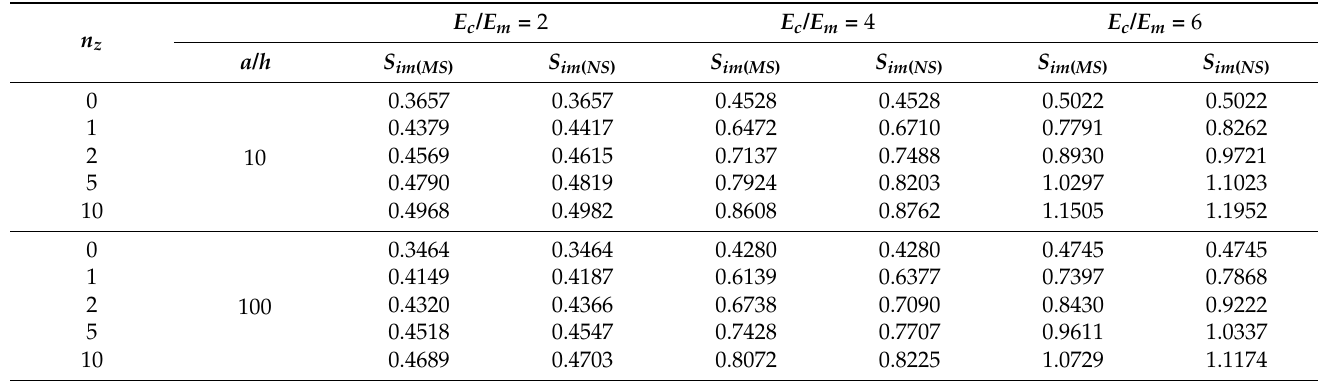
Table 5. Non-dimensional deflection w of a BDFG square immovable simply supported plate under sinusoidal load based on middle surface formulation S im − MS and neutral surface formulation S im − NS at n z = { 0,1,2,5,10 } , n x = 1 for different E c / E m and a / h